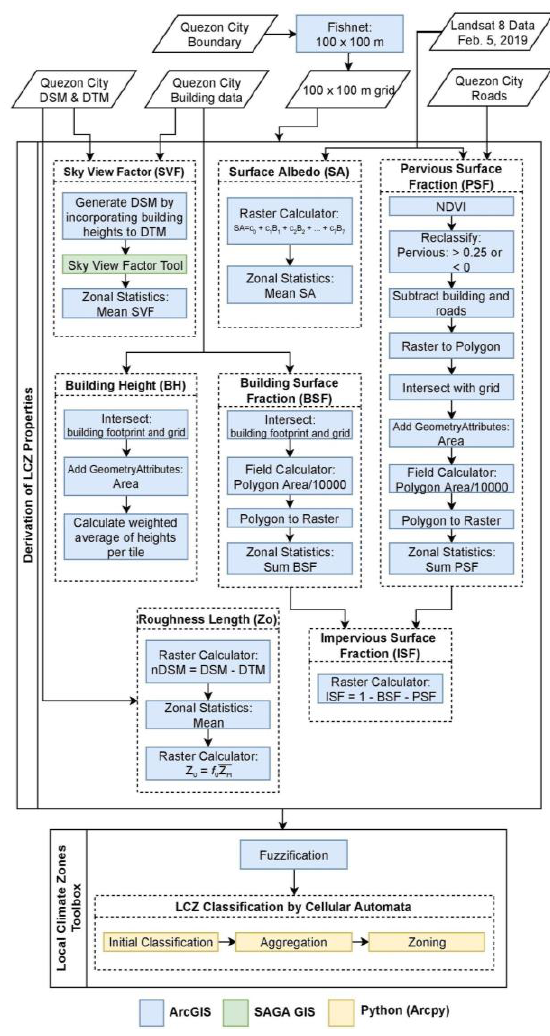
Figure 3. Workflow of the GIS-based mapping of LCZs